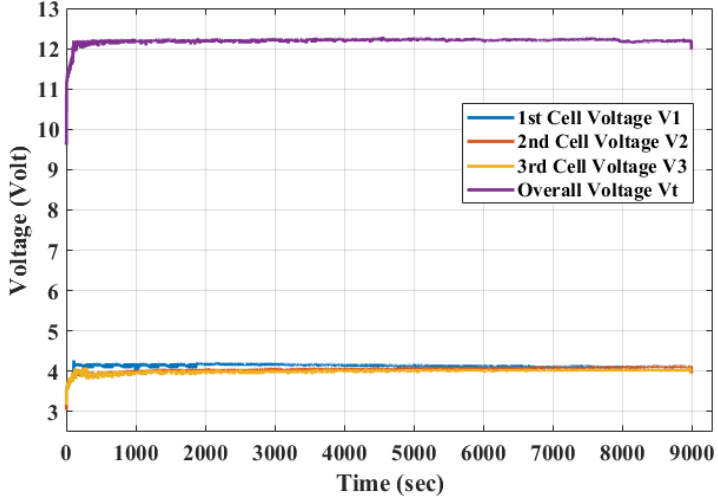
Figure 10. Charging profile of a lithium-ion battery at 1 C.